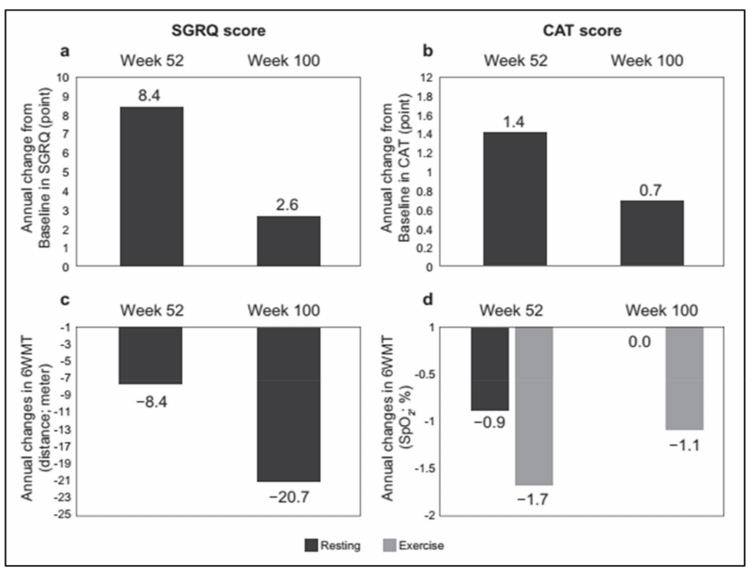
Figure 3. Secondary outcome trends in the treated group. Secondary outcomes with respect to ( a ) St. George’s respiratory questionnaire (SGRQ), ( b ) COPD assessment test (CAT), and ( c , d ) 6 min walk (6MWT) were scored as annual changes from the baseline at the end of weeks 52 and 100, to assess health-related quality of life, airway obstruction, and exercise-related pulmonary function,